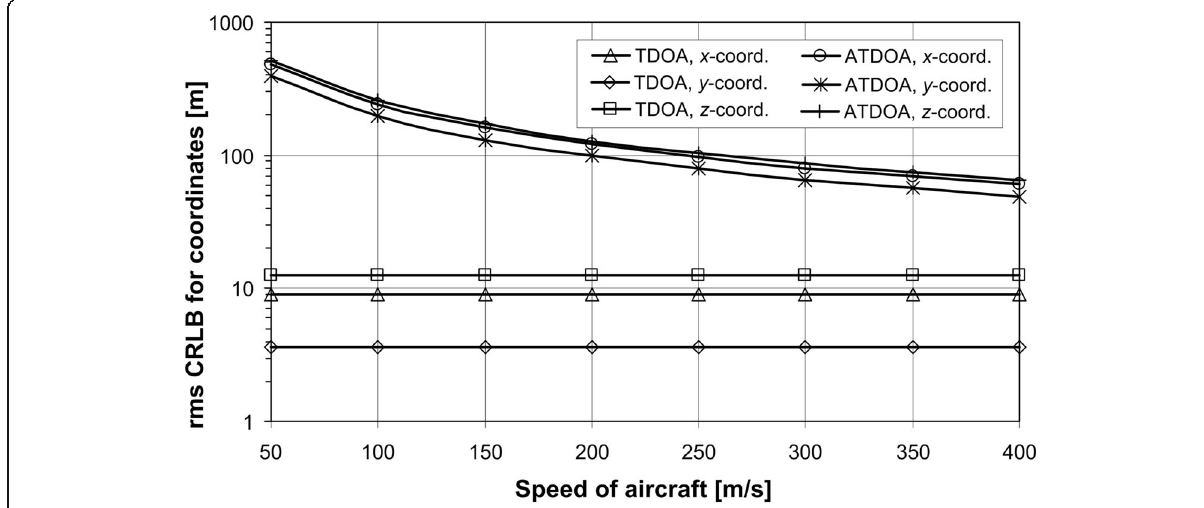
Fig. 8 RMS CRLB for coordinates versus the speed of the aircraft